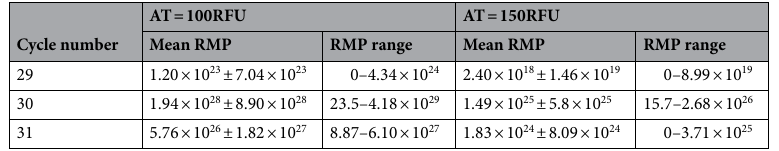
Table 3. Random match probabilities (calculated without theta corrections and the use of the “2p” rule) for profiles generated from single cells amplified with the PowerPlex Fusion 6c amplification kit using 29, 30, and 31 cycles and analyzed using analytical thresholds of 100 and 150RFU. AT analytical threshold.